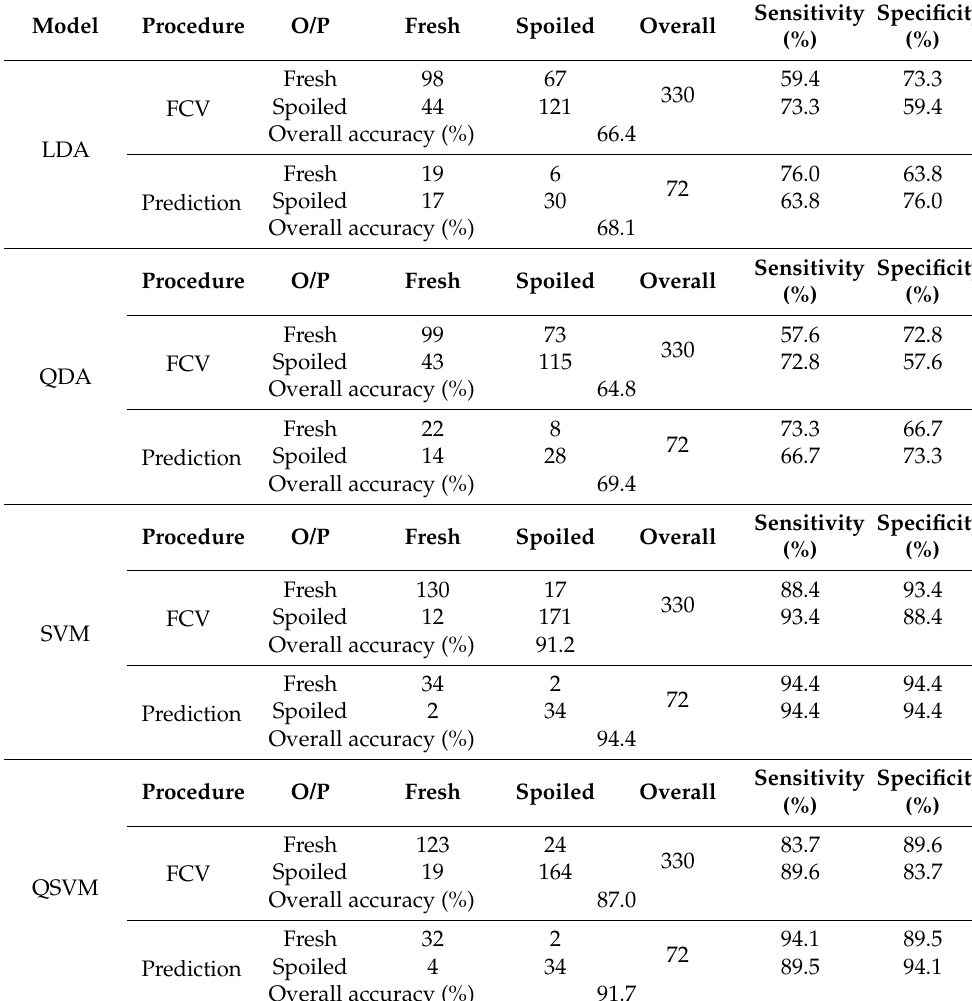
Table 4. Confusion matrix and performance indexes of the developed classification models (LDA, QDA, SVM, QSVM) regarding sensory quality discrimination of chicken thigh samples based on MSI spectral